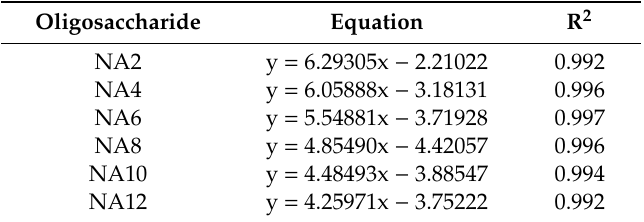
Figure 3. Analysis of enzymatic hydrolysates with different enzymolysis times, S-NAOS standards, Table 1. The regression equations of NAOS.